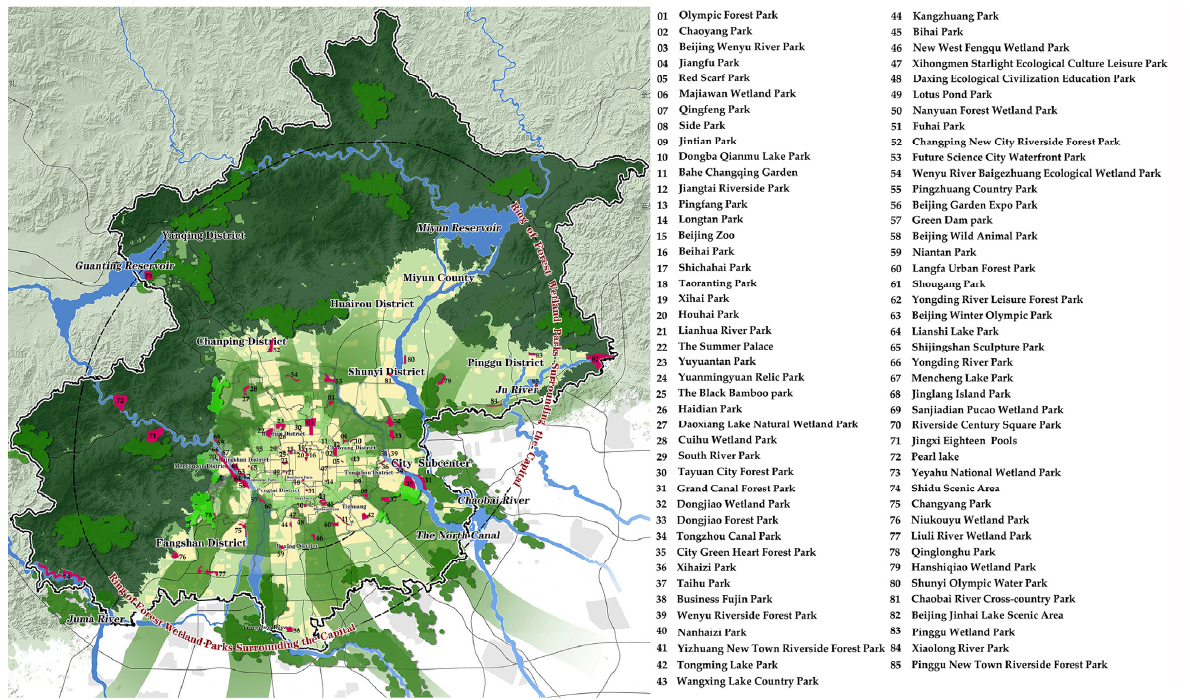
Figure 1. The distribution of riverside parks in 85 blue–green spaces.